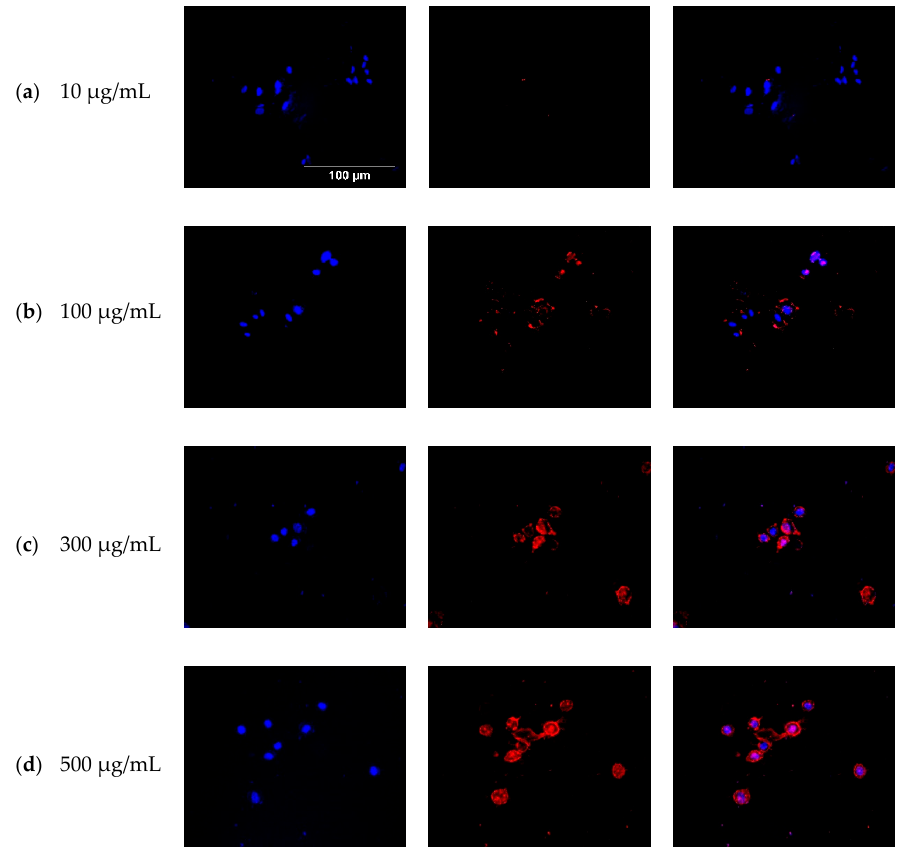
Figure 7. Intercellular uptake images of H460 cells treated with different concentrations: the concentration of the Eu(TTA) 3 (P(Oct) 3 ) 3 @mSiO 2 @SPION of ( a ) 10 μ g/mL, ( b ) 100 μ g/mL, ( c ) 300 μ g/mL and ( d ) 500 μ g/mL.